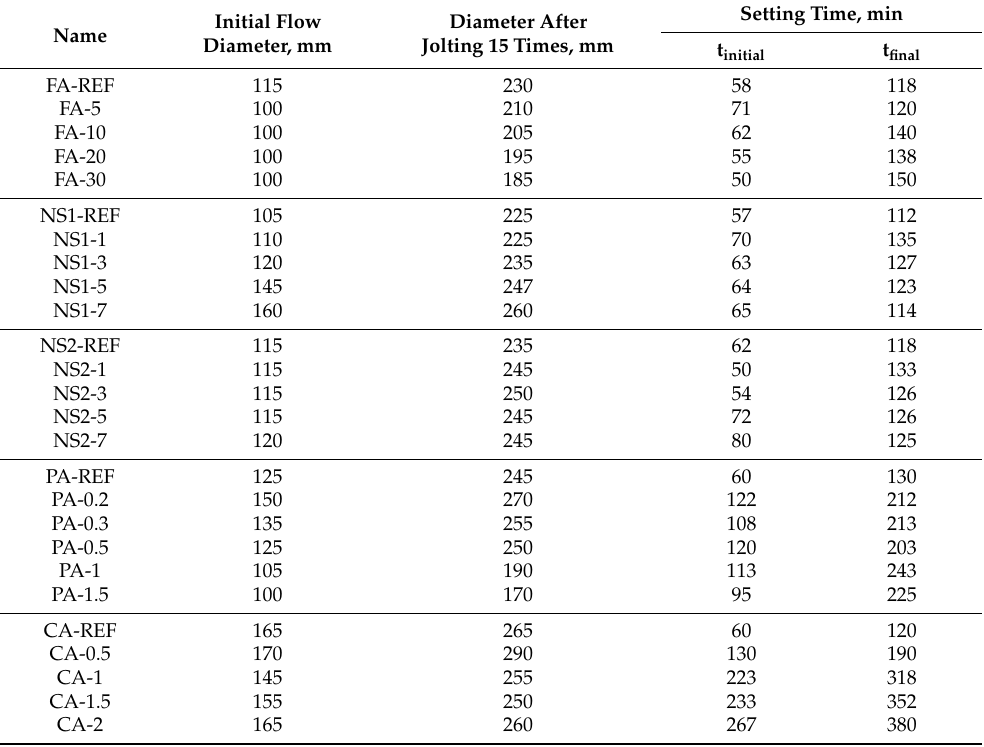
Table 5. Properties of the fresh MOC